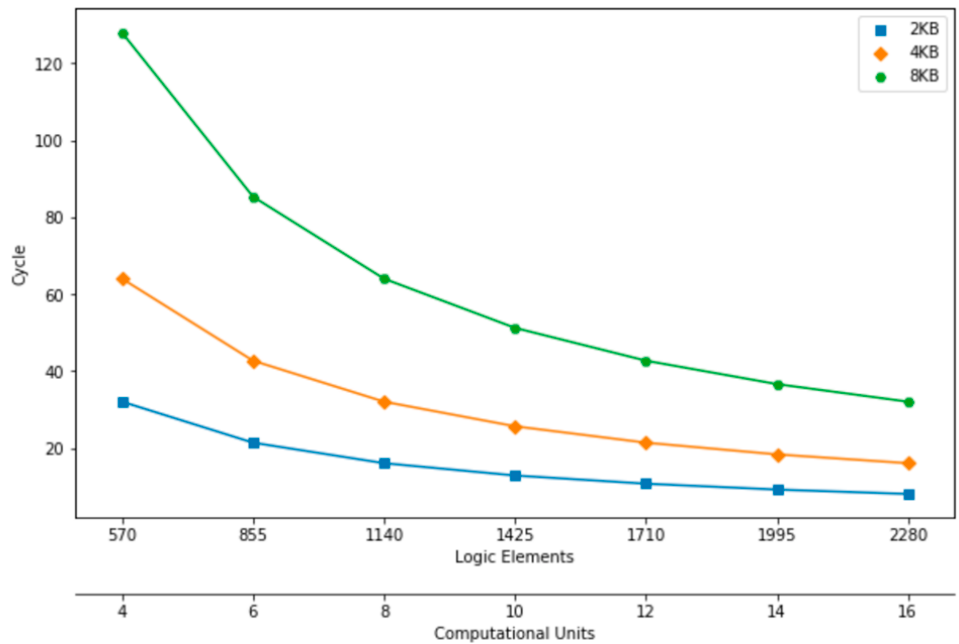
Figure 12. Number of cycles vs. logic elements for different data lengths.